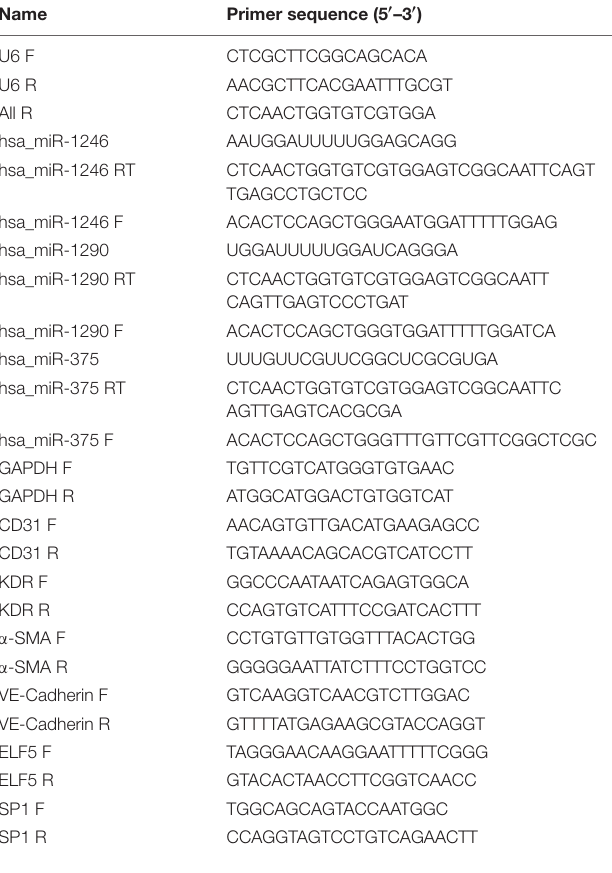
TABLE 1 | Primers for quantitative real-time